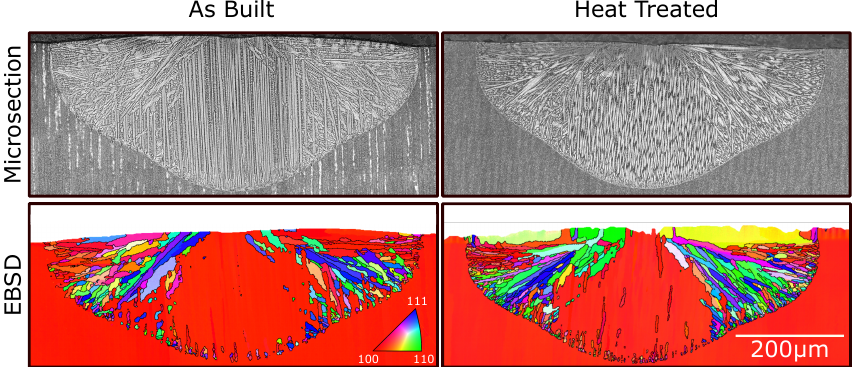
Figure 2. Microsections and EBSD images of a single-melt line (300 W and 0.25 ms − 1 ) in the as-built and heat treated SX base